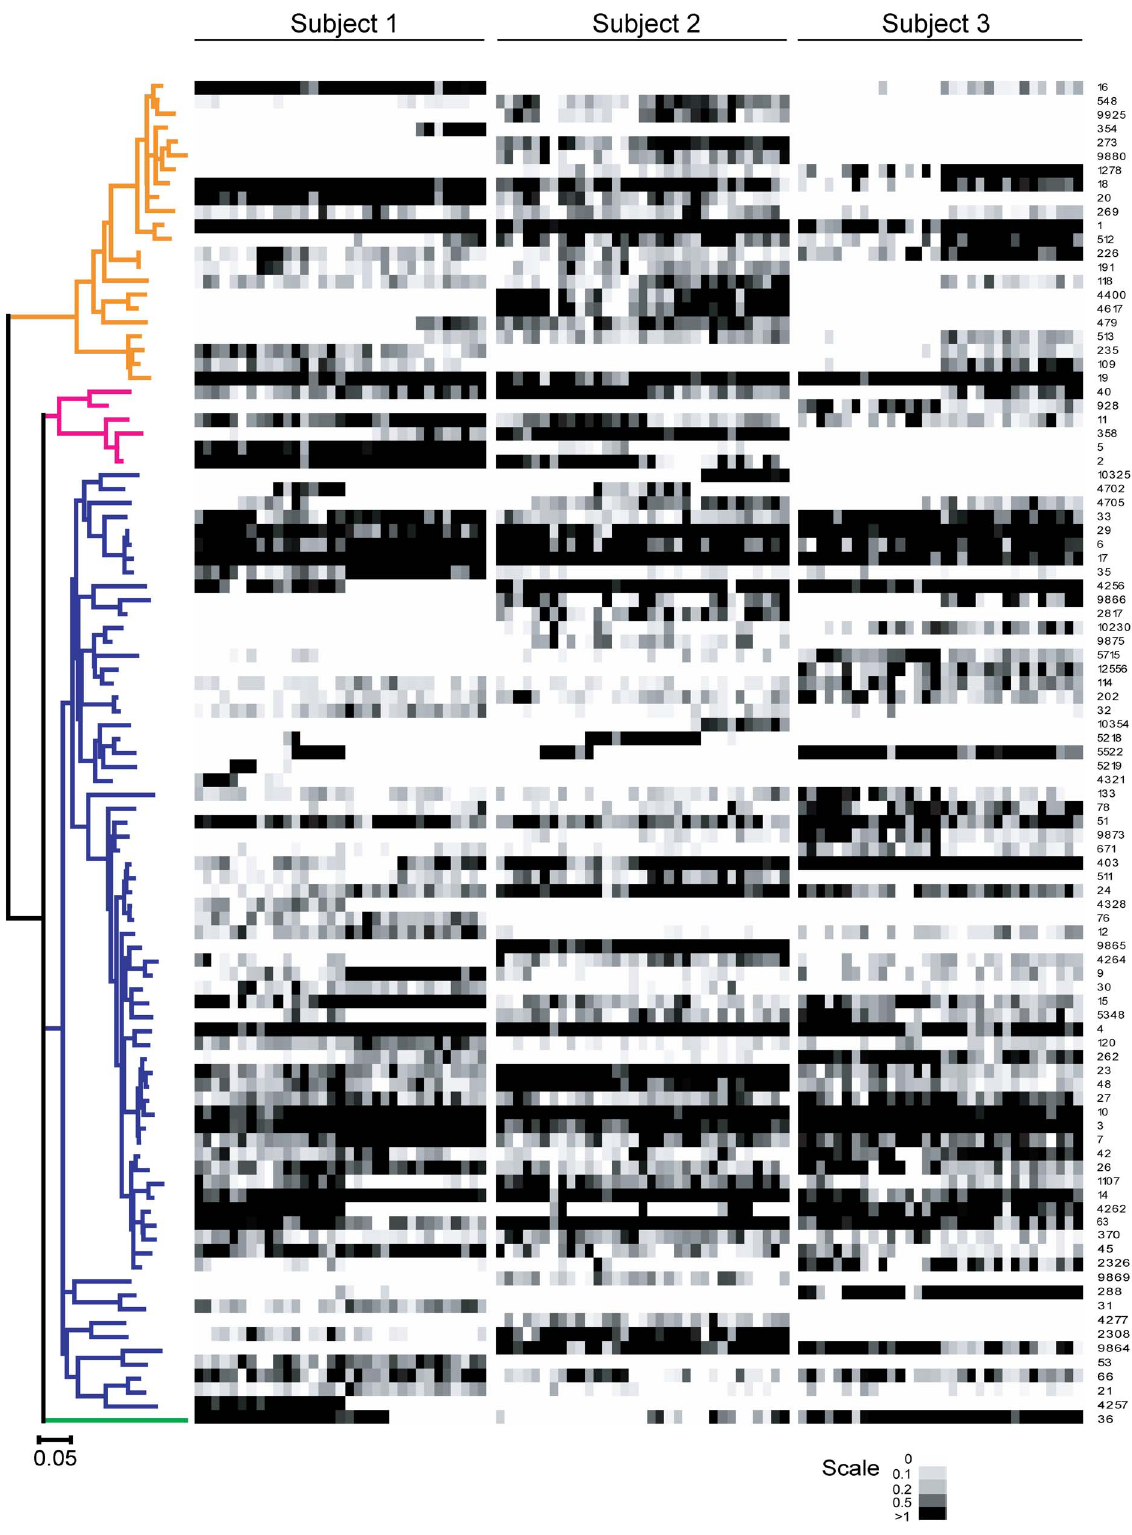
Figure 3. Abundance of the dominant bacterial OTUs in the fecal samples of subjects throughout the study. All OTUs that had an average proportion . 0.2% were included. Representative sequences of OTUs were used to construct the Maximum Likelihood phylogenetic tree, which is colored-coded according to phylum: Bacteroidetes (orange), Actinobacteria (magenta), Firmicutes (blue), Verrucomicrobia (green). The abundance of each phylotype is indicated by grayscale. The OTU numbers are presented to the right of the heatmap.